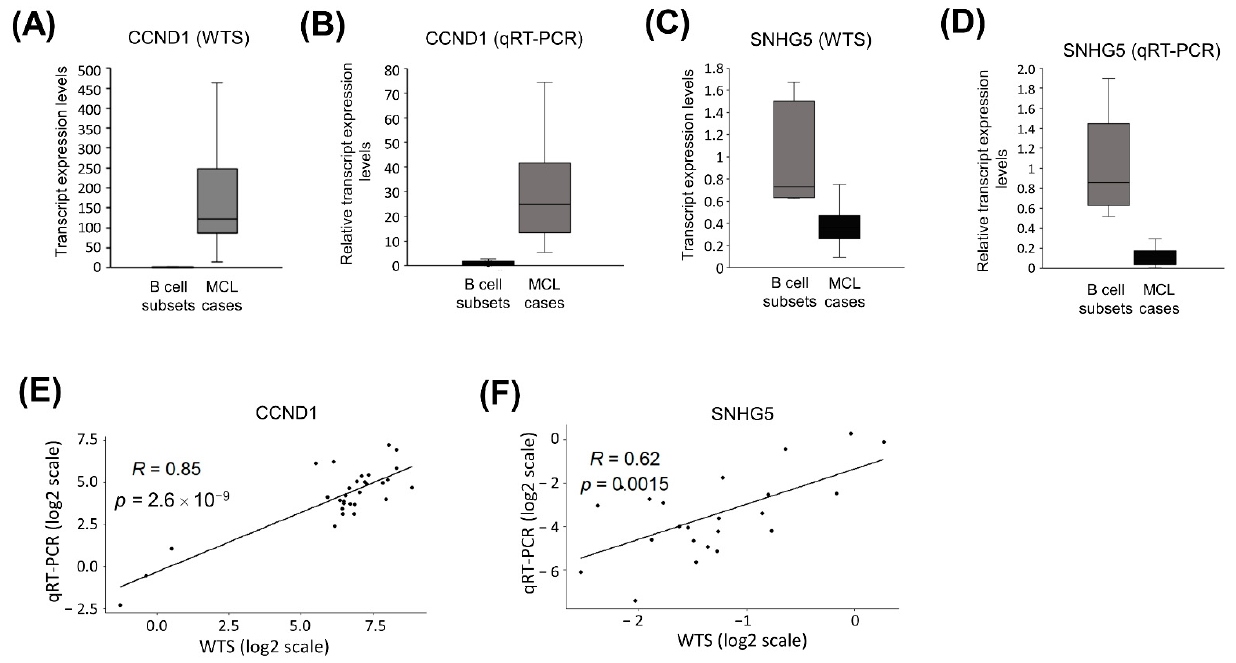
Figure 12. qRT-PCR cross-validates CCND1 and SNHG5 expression levels based on whole tran- scriptome sequencing. Box-and-whisker plots showing CCND1 mRNA WTS ( A ) and qRT-PCR ( B ) expression levels in MCL cases and control B-cell subsets. Box-and-whisker plots representing SNHG5 lncRNA WTS ( C ) and qRT-PCR ( D ). Linear correlation graphics comparing relative expres- sion levels based on whole transcriptome sequencing and qRT-PCR for CCND1 mRNA ( E ) or SNHG5 lncRNA ( F ). CCND1 linear correlation graphic involves one value for each of NBC, MBC, and CC B-cell subsets as well as values for 24 MCL tumor tissue samples. SNHG5 linear correlation graphic involves the same set of control sample values in addition to 22 MCL tumor tissue samples.